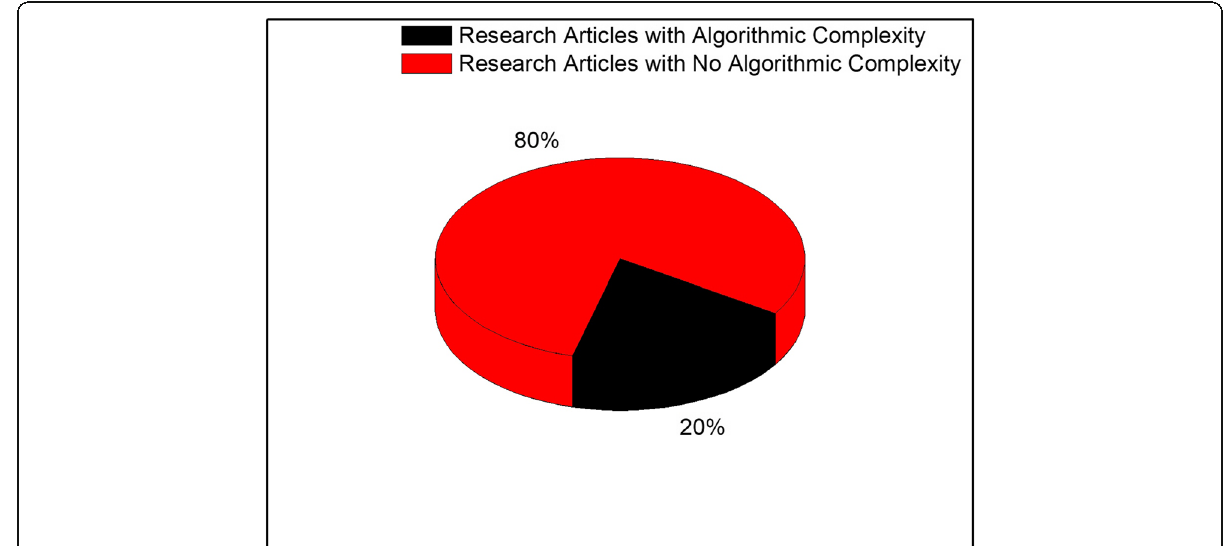
Fig. 8 Percentage of research articles designating algorithmic